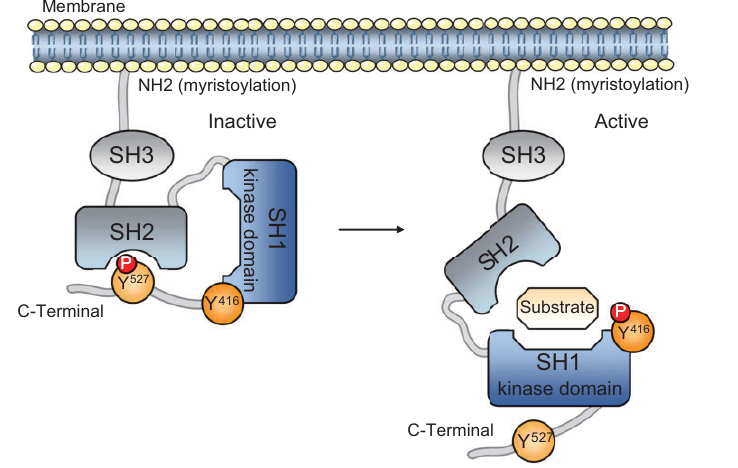
Figure 1 Molecular structure and activation of Src family